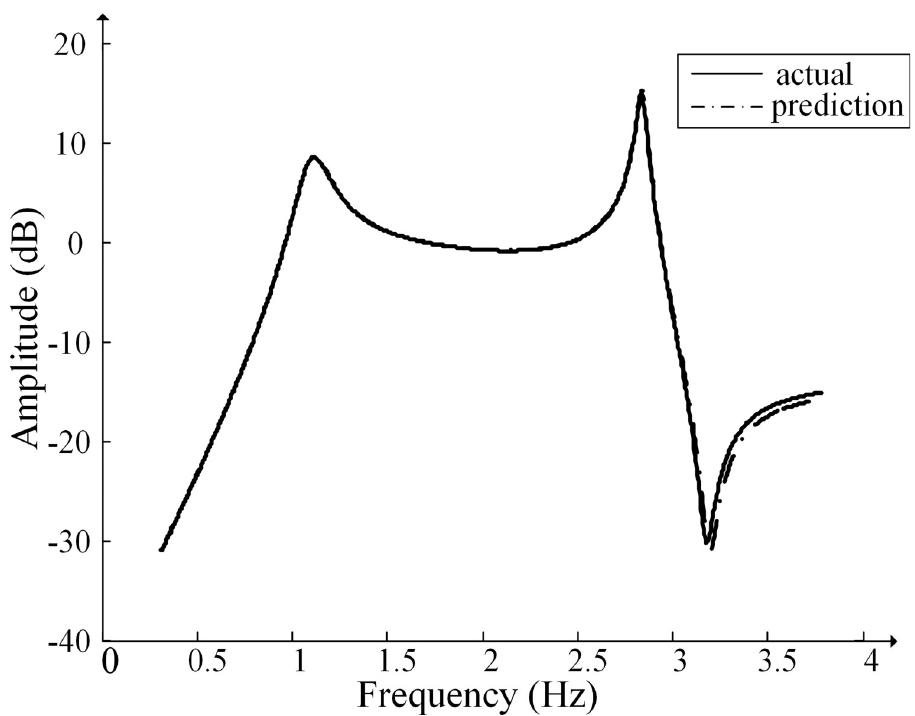
Fig 8. Fitting results of the amplitude of the transformation ratio.